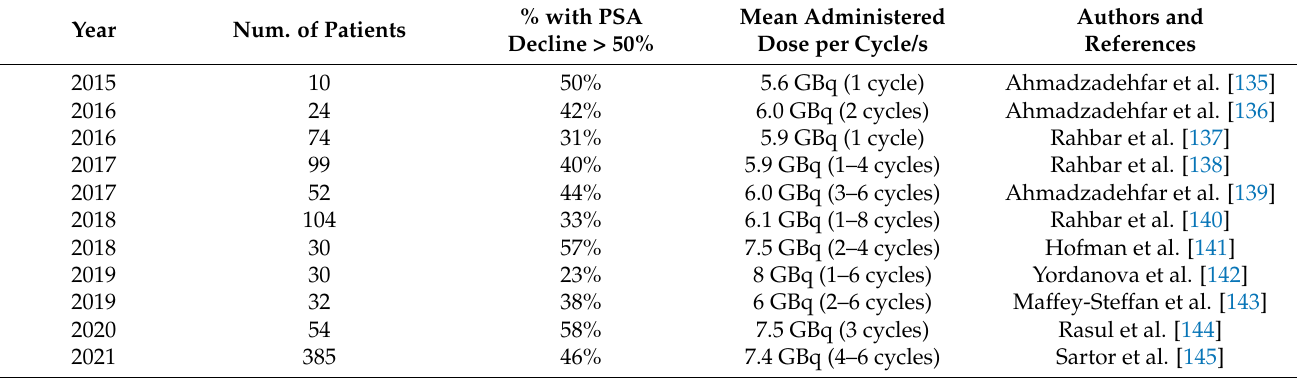
Table 2. The main retrospective analyses and clinical studies carried out with [ 177 Lu]Lu-PSMA-617. % with Year Num. of Patients